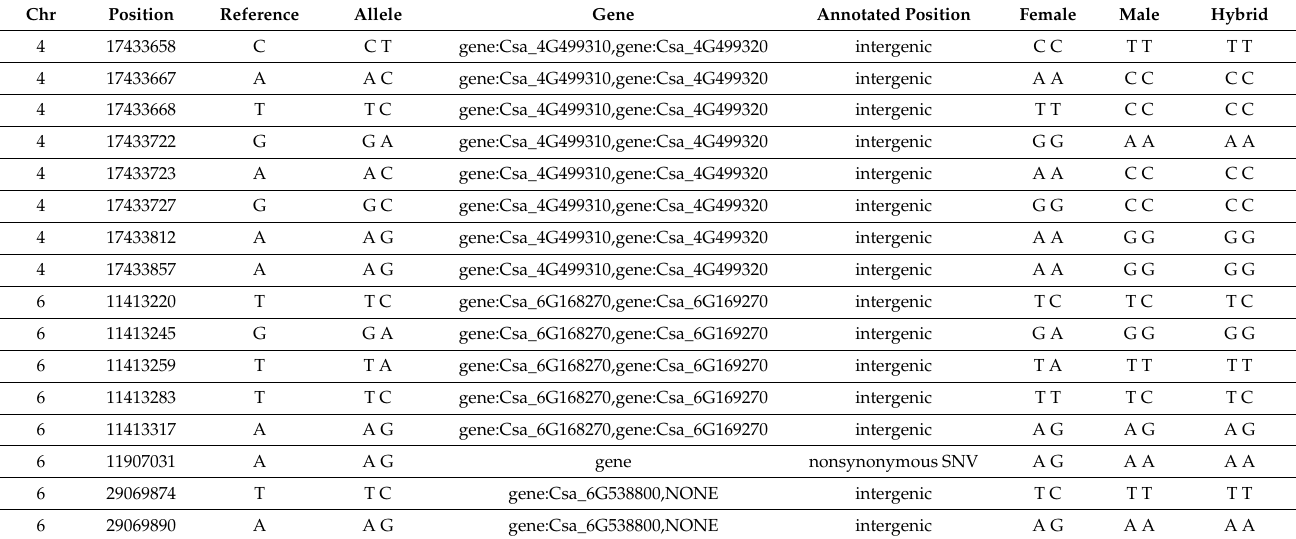
Table 6. List of SNPs identified in the vicinity of ACS1 and ACS2 genes that were retrieved from the NCBI Database.